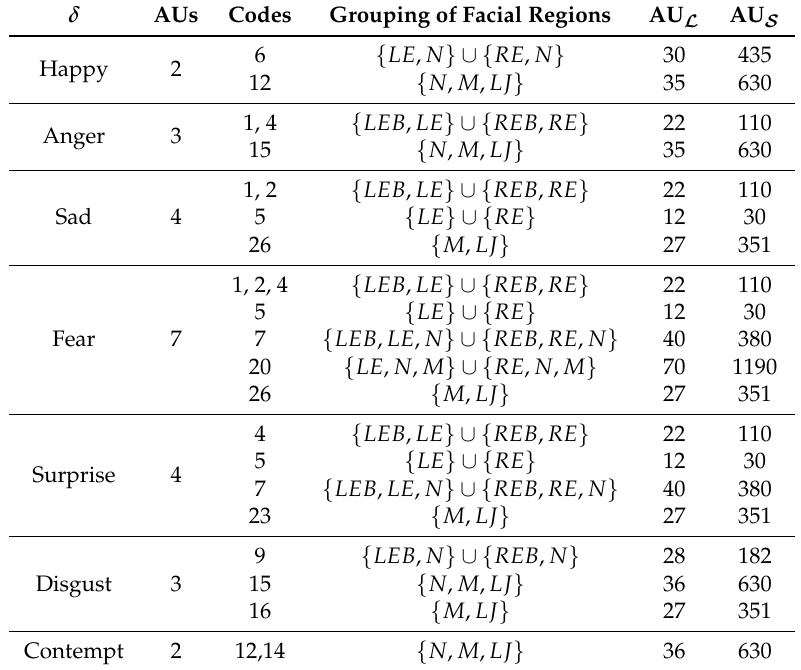
Table 2. Grouping of Action Unit (AU) facial regions of the proposed FACS-based graph. δ AUs Codes Grouping of Facial Regions AU L AU S